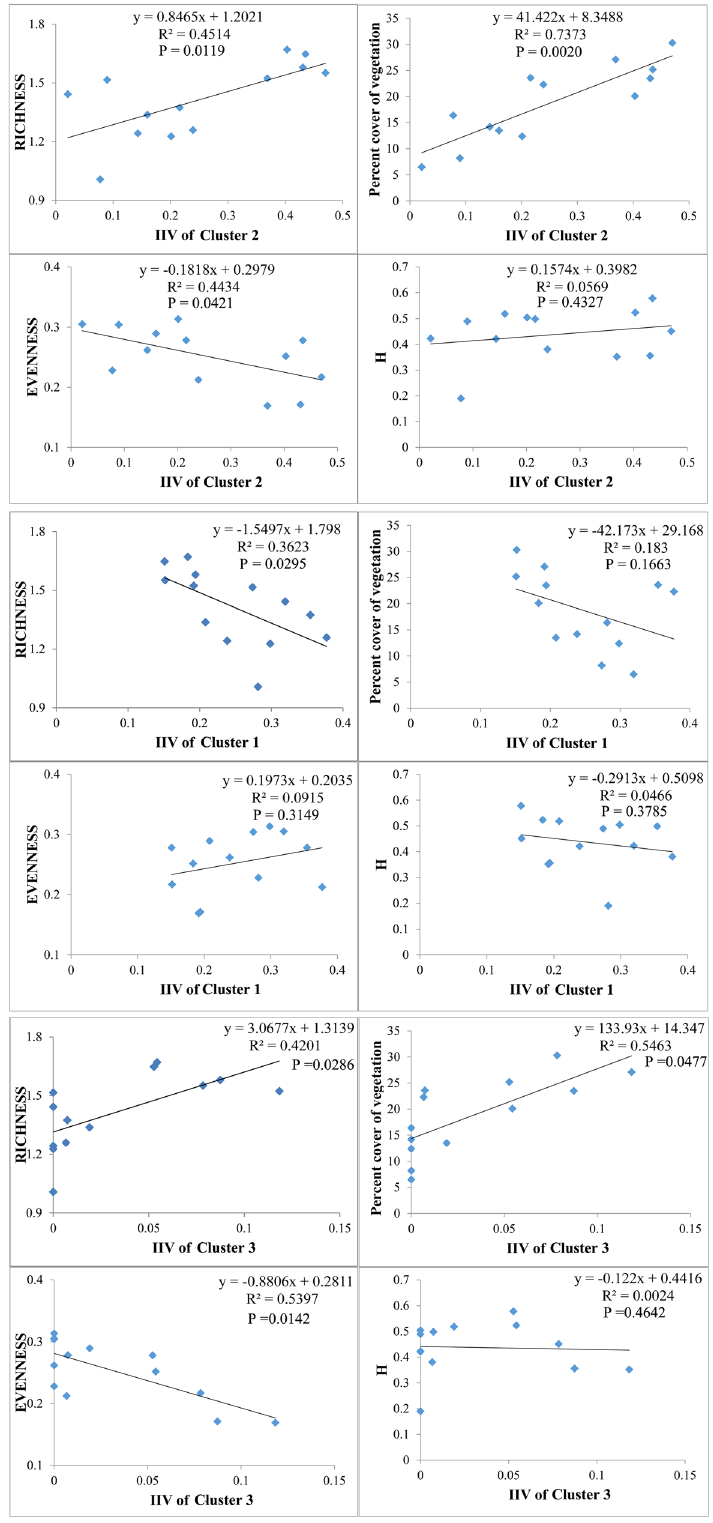
Figure 4. Correlations between the vegetation indices and IIVs of the plants species of three